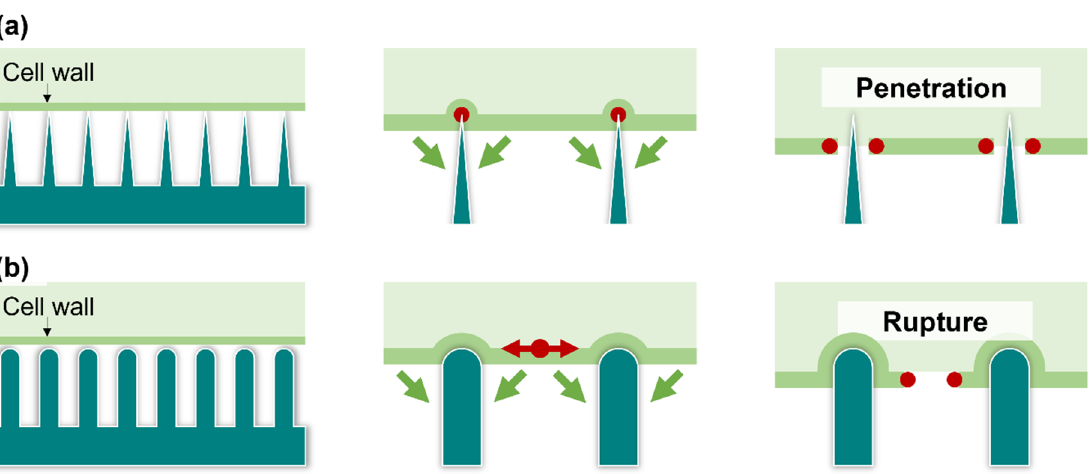
Figure 2. Mechanisms of bactericidal surfaces. ( a ) Penetration mechanisms shows that the cell wall of bacteria is penetrated by sharp structures of the bactericidal surface. ( b ) The stretching mechanism shows that the cell walls of bacteria may experience increased stretching tension and deformation as they land on nanostructures. The green arrows indicate the direction of cell wall movement on surface structures, and the red dots indicate the breakpoints of cell wall.